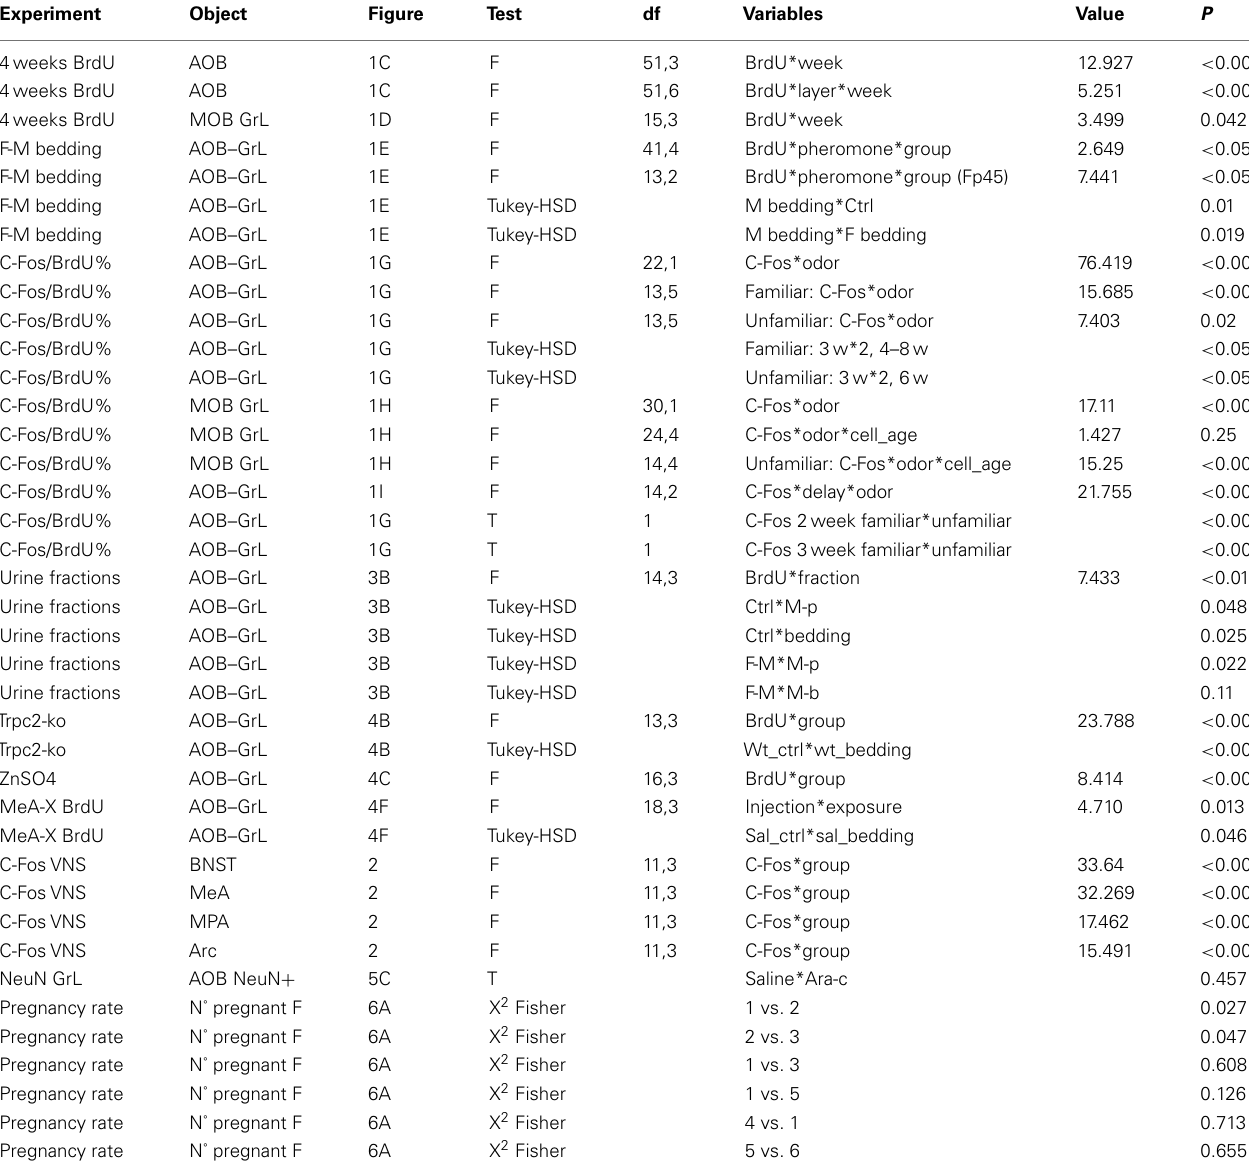
Table 1 | Results of all statistical analyses performed. Figure